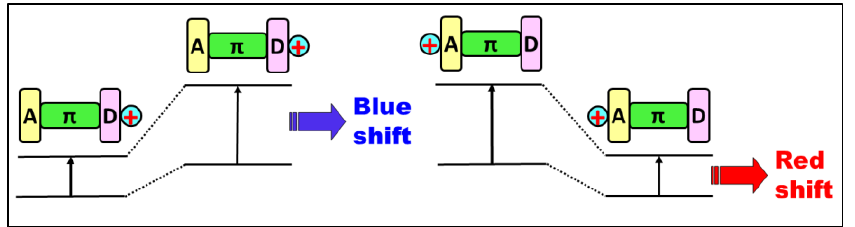
Figure 1. ICT probe based on cation interaction with an electron-donating or electron-withdrawing group.